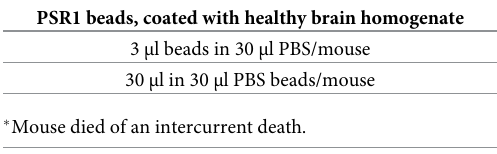
Table 1. Pilot experiment: Assessment of bead toxicity in tga20 . PSR1 beads, coated with healthy brain